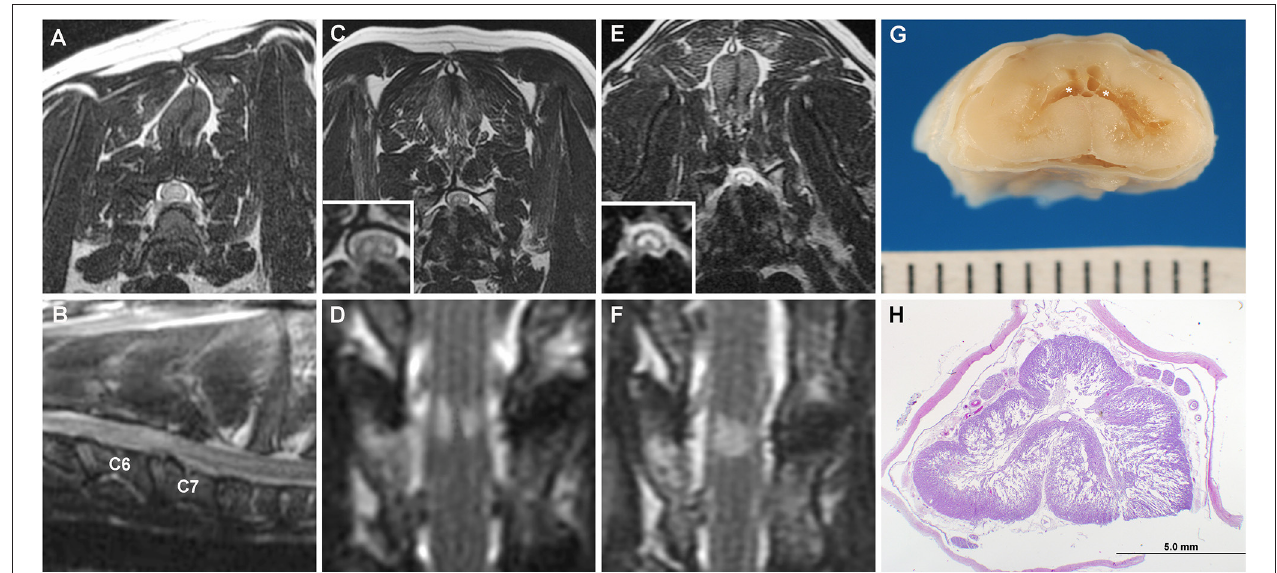
FIGURE 3 | Serial MRI and neuropathology of Case 3. T2W transverse (A) and parasagittal images (B) at the time of initial diagnosis of C6-C7 CSM demonstrating no ISC within the spinal cord. Transverse (C) T2W and dorsal STIR (D) obtained 6 years after initial surgery revealing bilaterally symmetric hyperintense SEM-like lesions in the ventral gray matter overlying the C6-C7 disc space. On MRI examination obtained 2 years after panels (C,D) , the previously noted SEM-like lesions have coalesced into a singular T2W/STIR hyperintense intramedullary lesion involving all gray matter regions (E,F) , and spinal cord atrophy has also progressed at the C6-C7 site. (G) Geographic cavitation (asterisks) and gray matter necrosis is present in the gross specimen of the C6 spinal cord segment. (H) Bilateral cavitation and necrosis of the gray matter is evident on a histologic section of the C6 spinal cord with vacuolization extending into the surrounding white matter. H&E